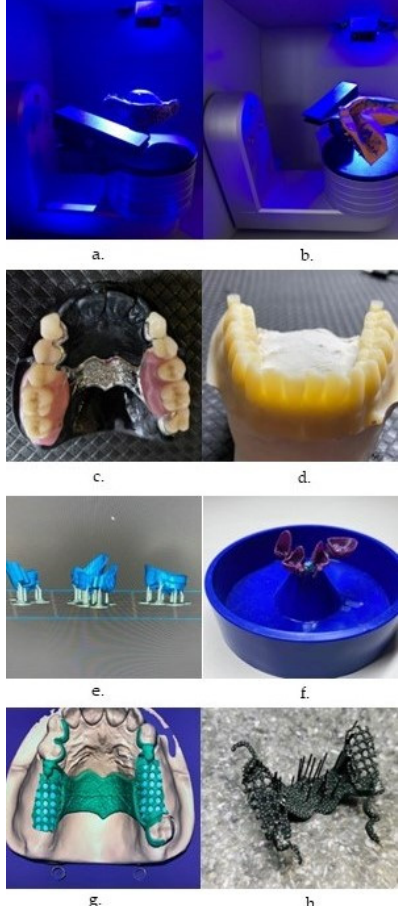
Figure 14. Combining different technologies, in manufacturing a removable partial denture. ( a , b ) Scanning the impressions; ( c , d ) 3D-printed models; ( e ) Digital design of the patterns; ( f ) 3D-printed copings pattern; ( g ) Digital design of the framework; ( h ) SLM 3D-printed metallic framework. Different types of orthodontic appliances may be manufactured by 3D printing, in- cluding aligners, custom brackets, occlusal splints, mouth guards, retainers, expanders, sleep apnea appliances, with better intraoral adaptation then regular ones [163–166]. In endodontics 3D printing has been involved in guided access cavity, guided root canal treatment and endo guided-surgical procedures, maneuvering obliterated pulp ca- nals, and auto transplantation [167].